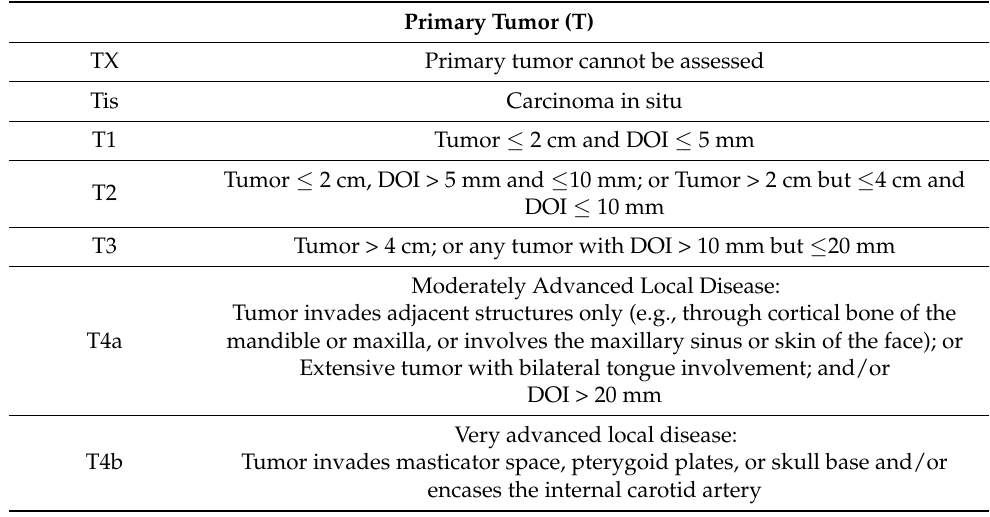
Table 1. American Joint Committee on Cancer (AJCC) 8th edition staging criteria for oral cavity